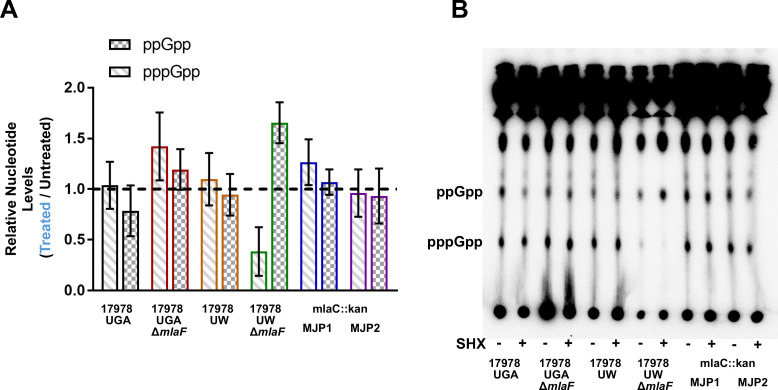
Quantification of (p)ppGpp levels after serine hydroxamate treatment at 100 µg/mL.Cultures were treated identically to that of Figure 6A except with the addition of 32P. Cultures were normalized by OD600 and equivalent OD units were harvested for each sample. Nucleotides were extracted and separated by TLC as described in the methods. Due to an overall lower OD600, UW ΔmlaF strains were loaded equivalently but less than other genotypes tested. (A) Densitometry was normalized by comparing treated versus untreated for both pppGpp and ppGpp and is biological triplicates. (B) Representative TLC image.